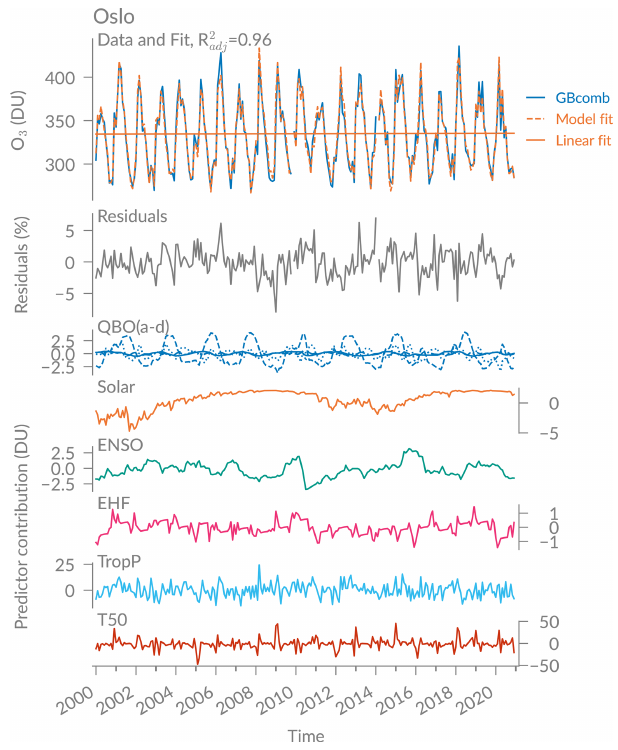
Figure 5. Regression fit, residuals, and predictor contribution ( β n · X n , with coefficient β n and predictor X n ) at Oslo.